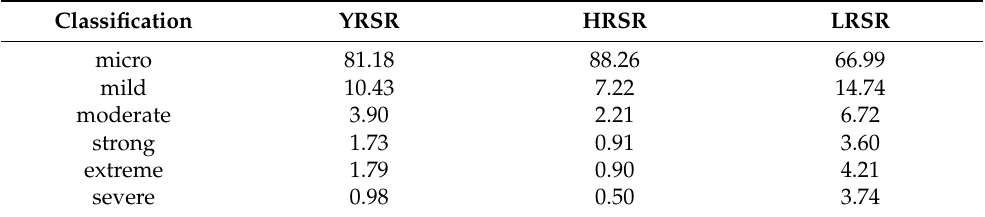
Table 2. Area percentage of soil erosion classification of the three source regions in the TRHR, China.